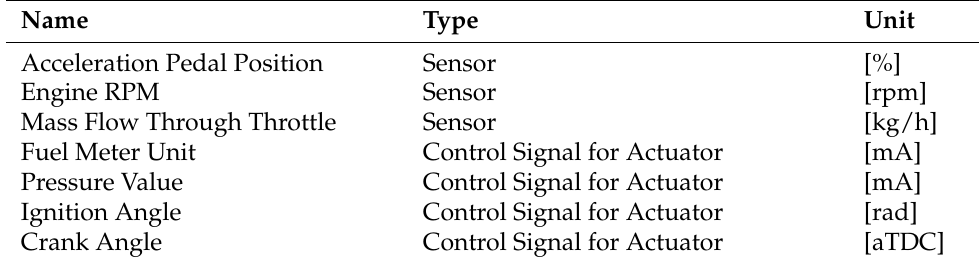
Table 3. Selected location of fault occurrence.